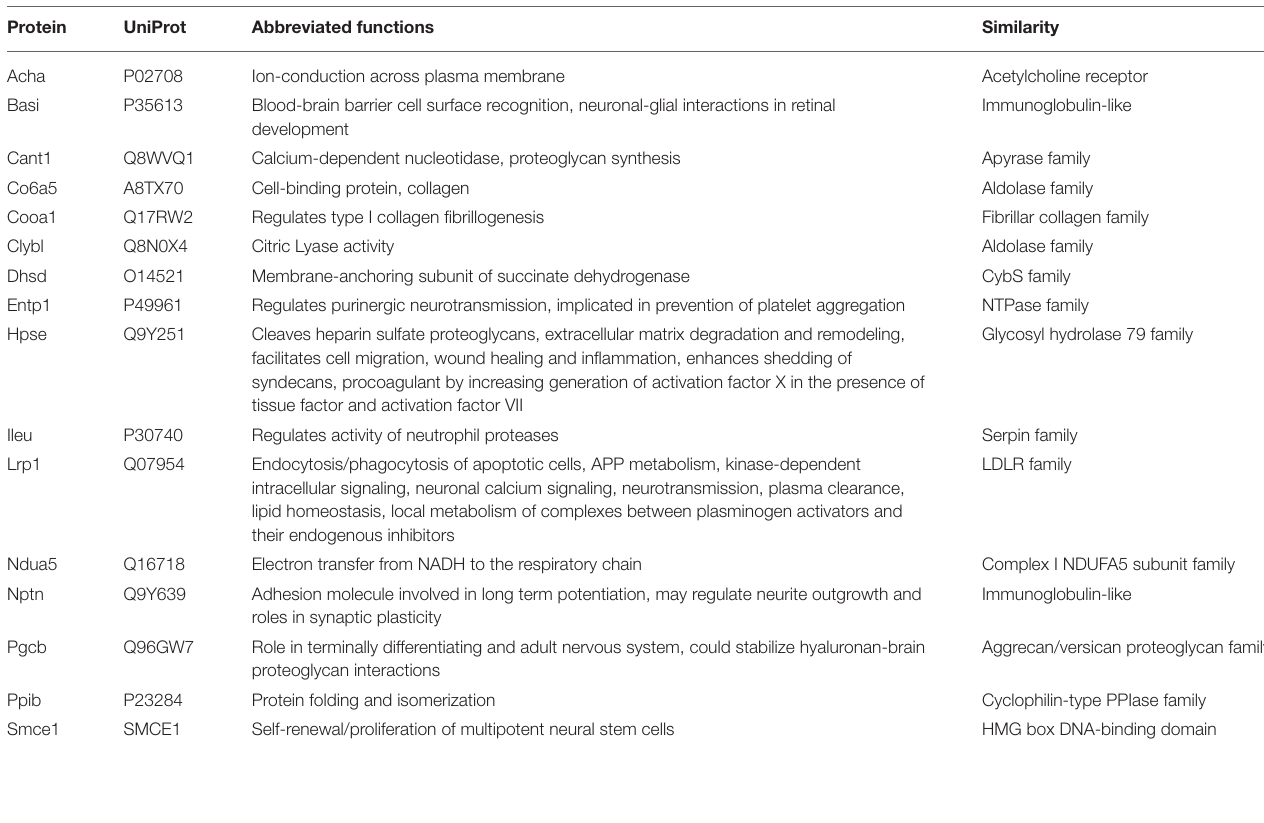
TABLE 3 | Description of shared leech and vampire bat salivary gland products. Protein UniProt Abbreviated functions Similarity